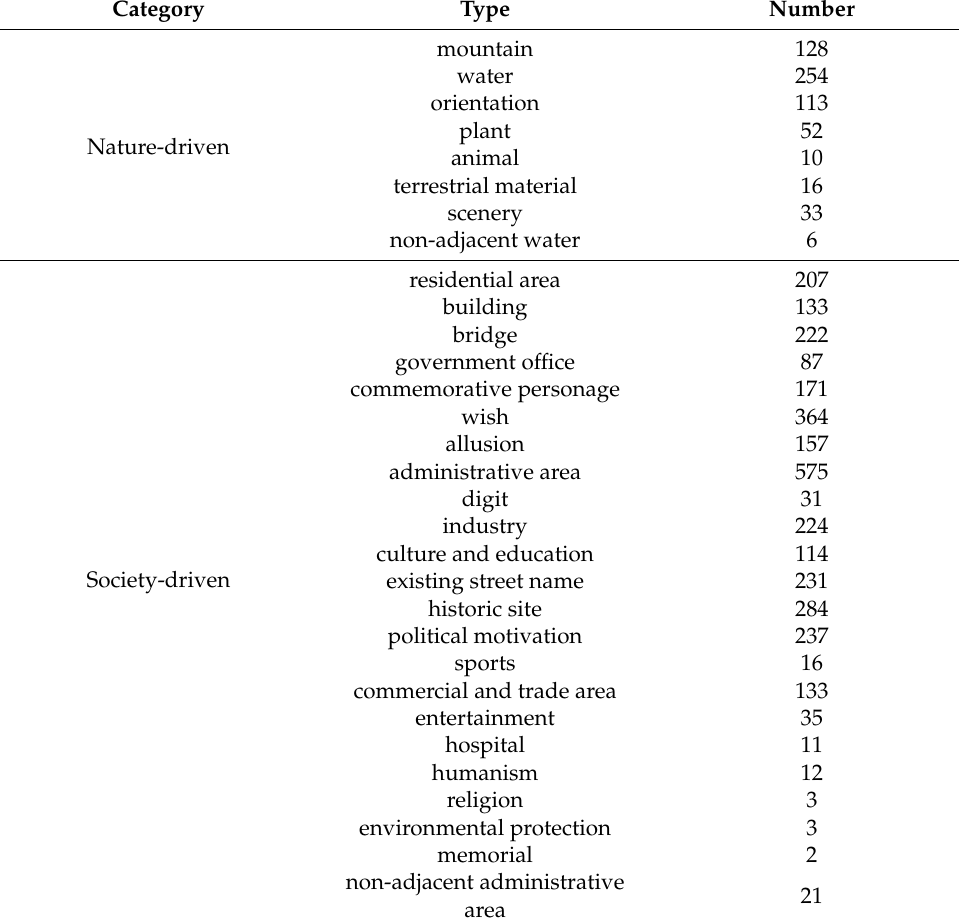
Table 2. Street name categories and